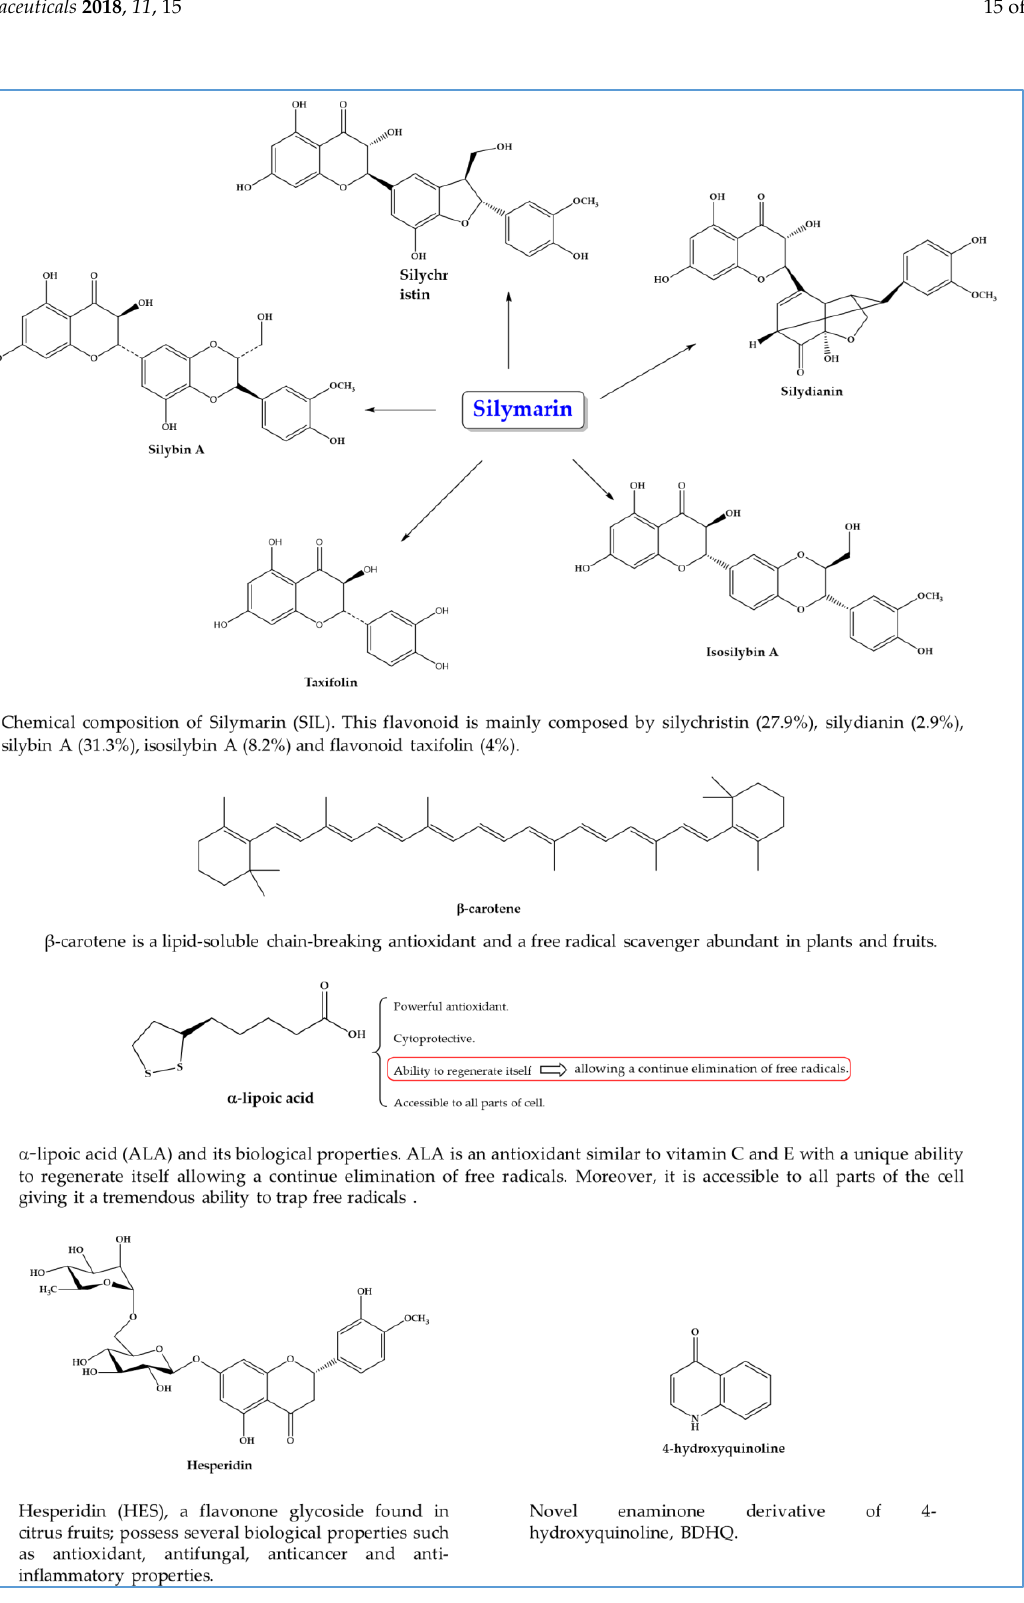
Figure 5. Chemical structures of compounds with antioxidant properties against schistosomiasis.